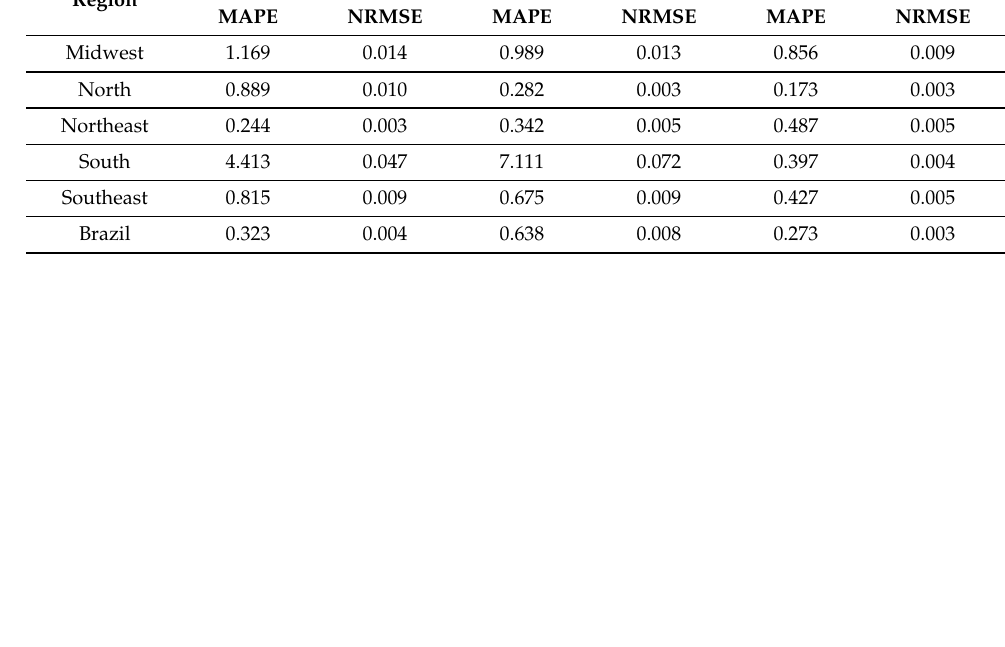
Table 6. Tabulated errors with respect to predictions depicted in Figure 12 (Brazilian regions). Cases Recoveries Region